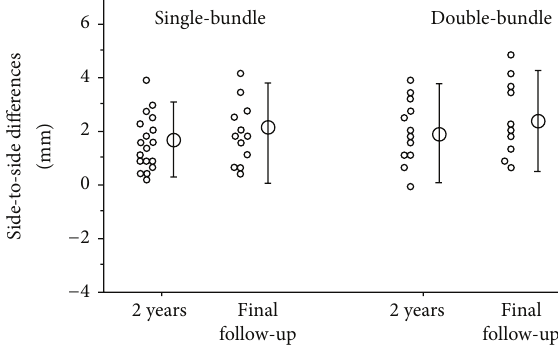
Figure 4: This graph shows the side-to-side differences by gravity sag view. The data represent operated side values minus the opposite side. There were no significant differences between single- and double-bundle procedures or between results at 2 years and > 10 years.